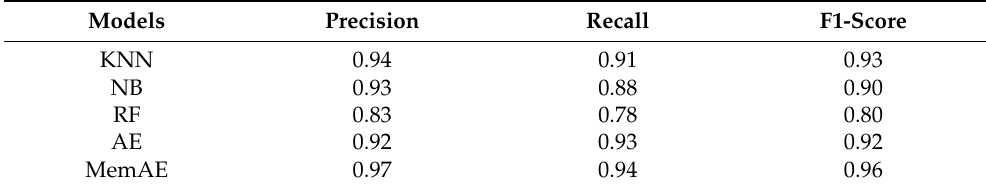
Table 8. Malicious behavior detection results by model using the preprocessed dataset (ADASYN). Models